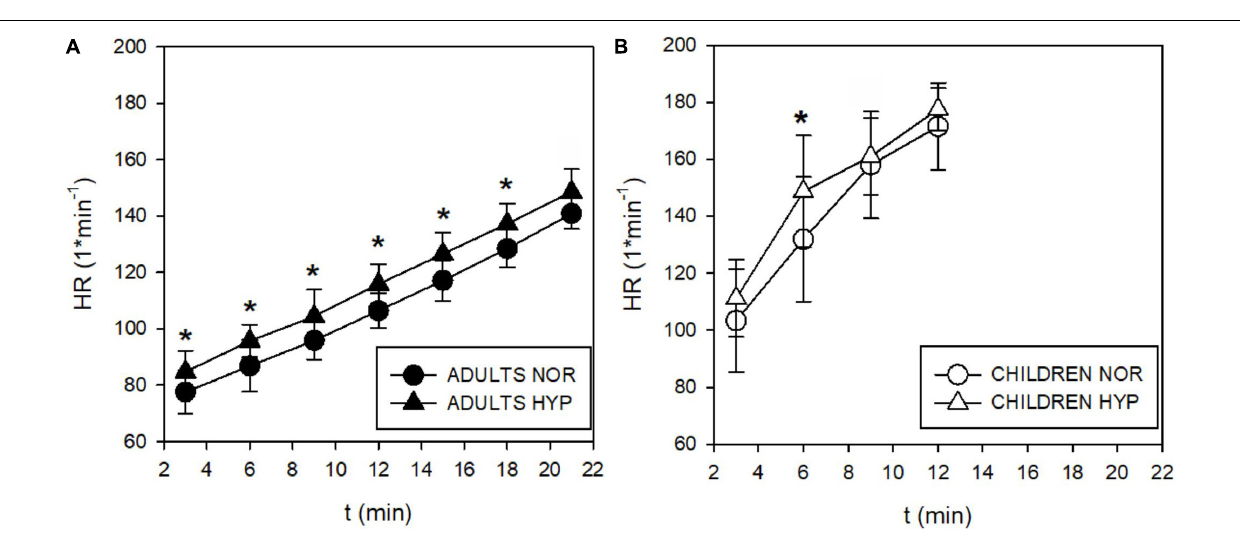
). The difference starts above VT. ˙ Vo 2 didn’t show any influence of hypoxia in adults. ). (cid:32) (cid:32)